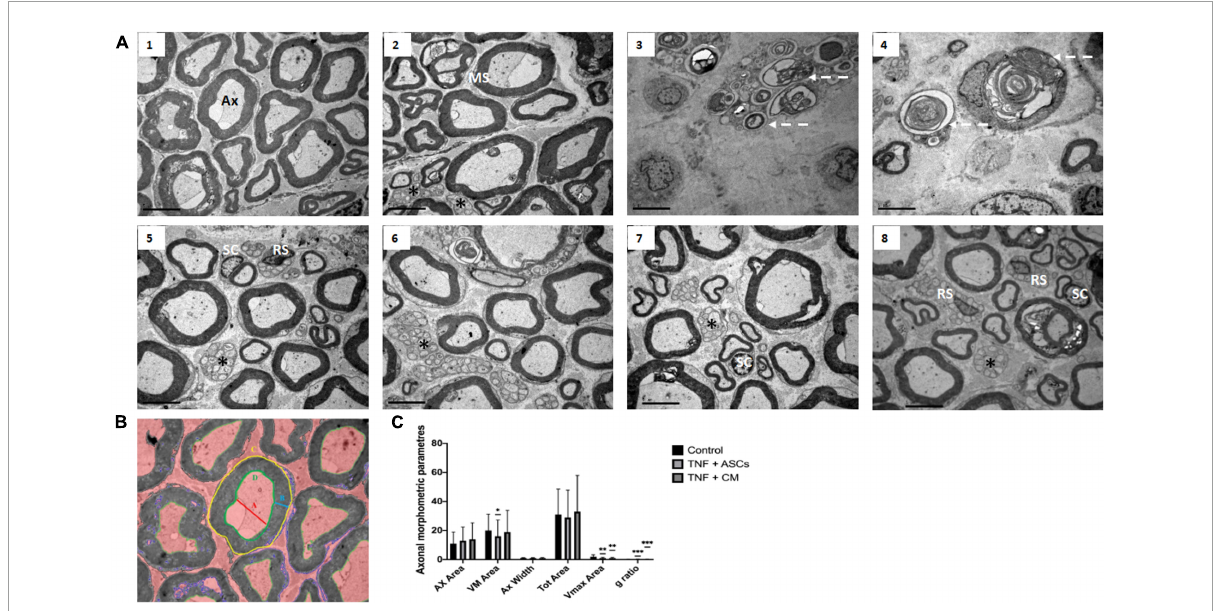
FIGURE4 Rat sciatic nerve ultrastructure: (A) Representative images of transmission electron micrographs of rat sciatic nerves. (1,2) Control group showing normal axons (Ax) surrounded by a myelin sheath (MS). (3,4) TNF-treated group showing degenerated axons in (dotted white arrows) surrounded by remnants of degenerated myelin sheaths. (5,6) TNF+ASCs group showing unmyelinated axons (asterisks), myelinated Schwann cells (SC) and Remak Schwann cells (RS). (7,8) TNF+CM group showing enlarged Schwann cells (SC) surrounding some of the axons. Scale: 1 µ m. (B) Axon parameters calculated for the in vivo rat model. A: axon internal diameter (AX width); B: myelin sheath width (VMax Area); C: total axon area (Tot Area); D: axon area (AX Area); E: g ratio = {(A/2)/[B+(A/2)]}. (C) Histograms comparing axon parameters for the three different groups (Control, TNF+ASCs, TNF+CM). We were not able to obtain any meaningful measurements of axon parameters for the TNF group since the nerves in these samples were unstructured and the relevant parameters could not be clearly identified. The results of morphometric analyses are expressed as the mean ± SD of three independent experiments and we analyzed 10 separate images for each experimental group were analyzed. ∗ p ≤ 0.05 versus control group, ∗∗ p ≤ 0.01 versus control group, ∗∗∗ p ≤ 0.001 versus control